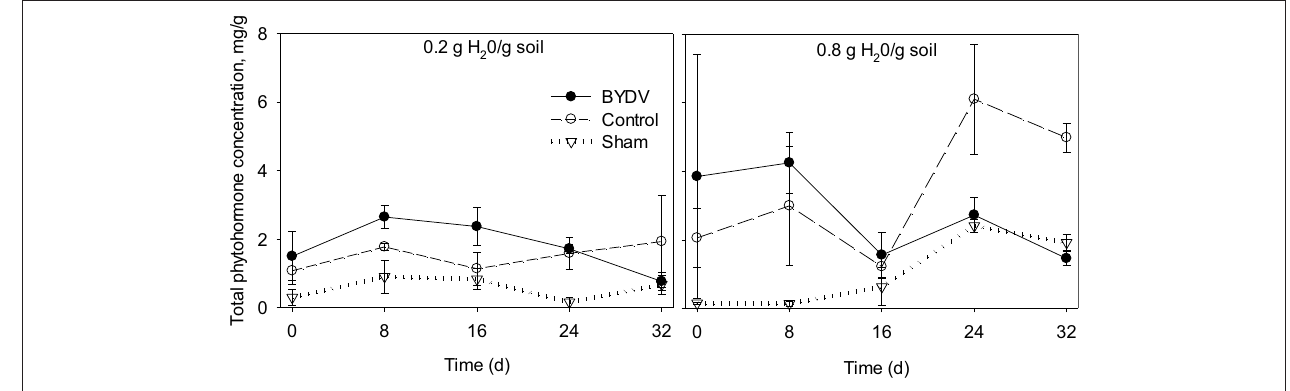
FIGURE 1 | Time series tracking changes in the summed concentrations of five phytohormones (abscisic acid, jasmonic acid, methyl jasmonate, methyl salicylate, and salicylic acid) in wheat leaves in response to two watering treatments (0.2 and 0.8g H 2 0/g soil) and three virus infection treatments (BYDV, sham treatment, and nondamaged control). Bars show one standard error of the mean.